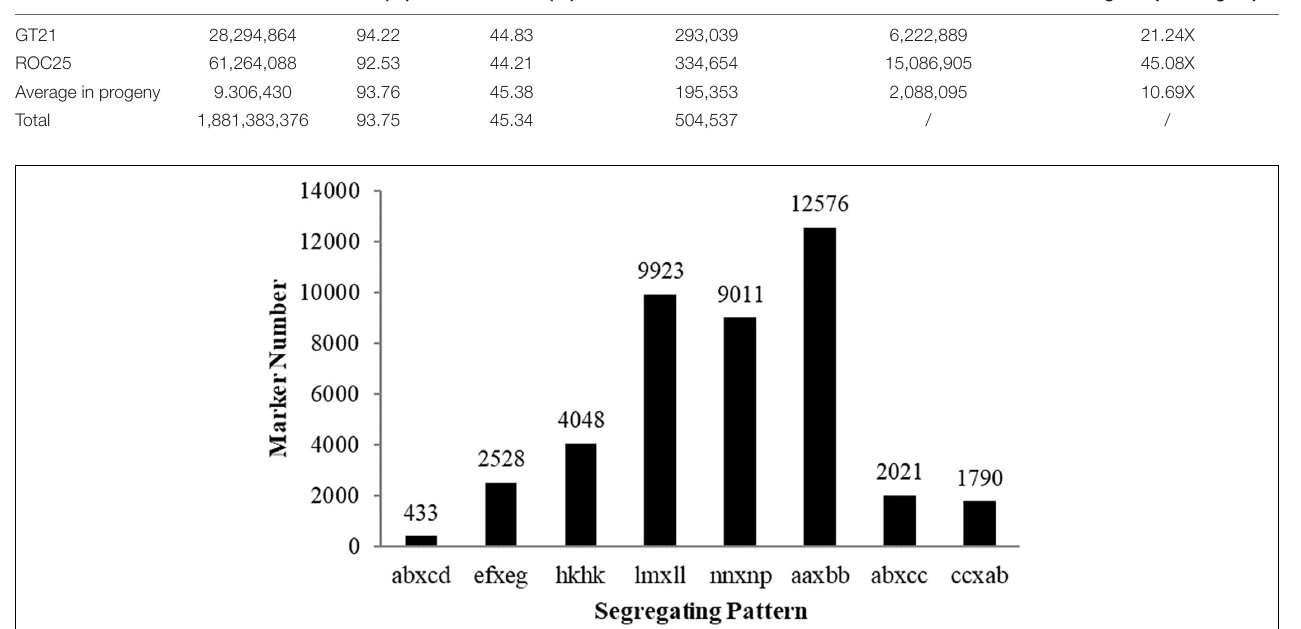
FIGURE 2 | Number of sugarcane SLAF markers in the eight segregation